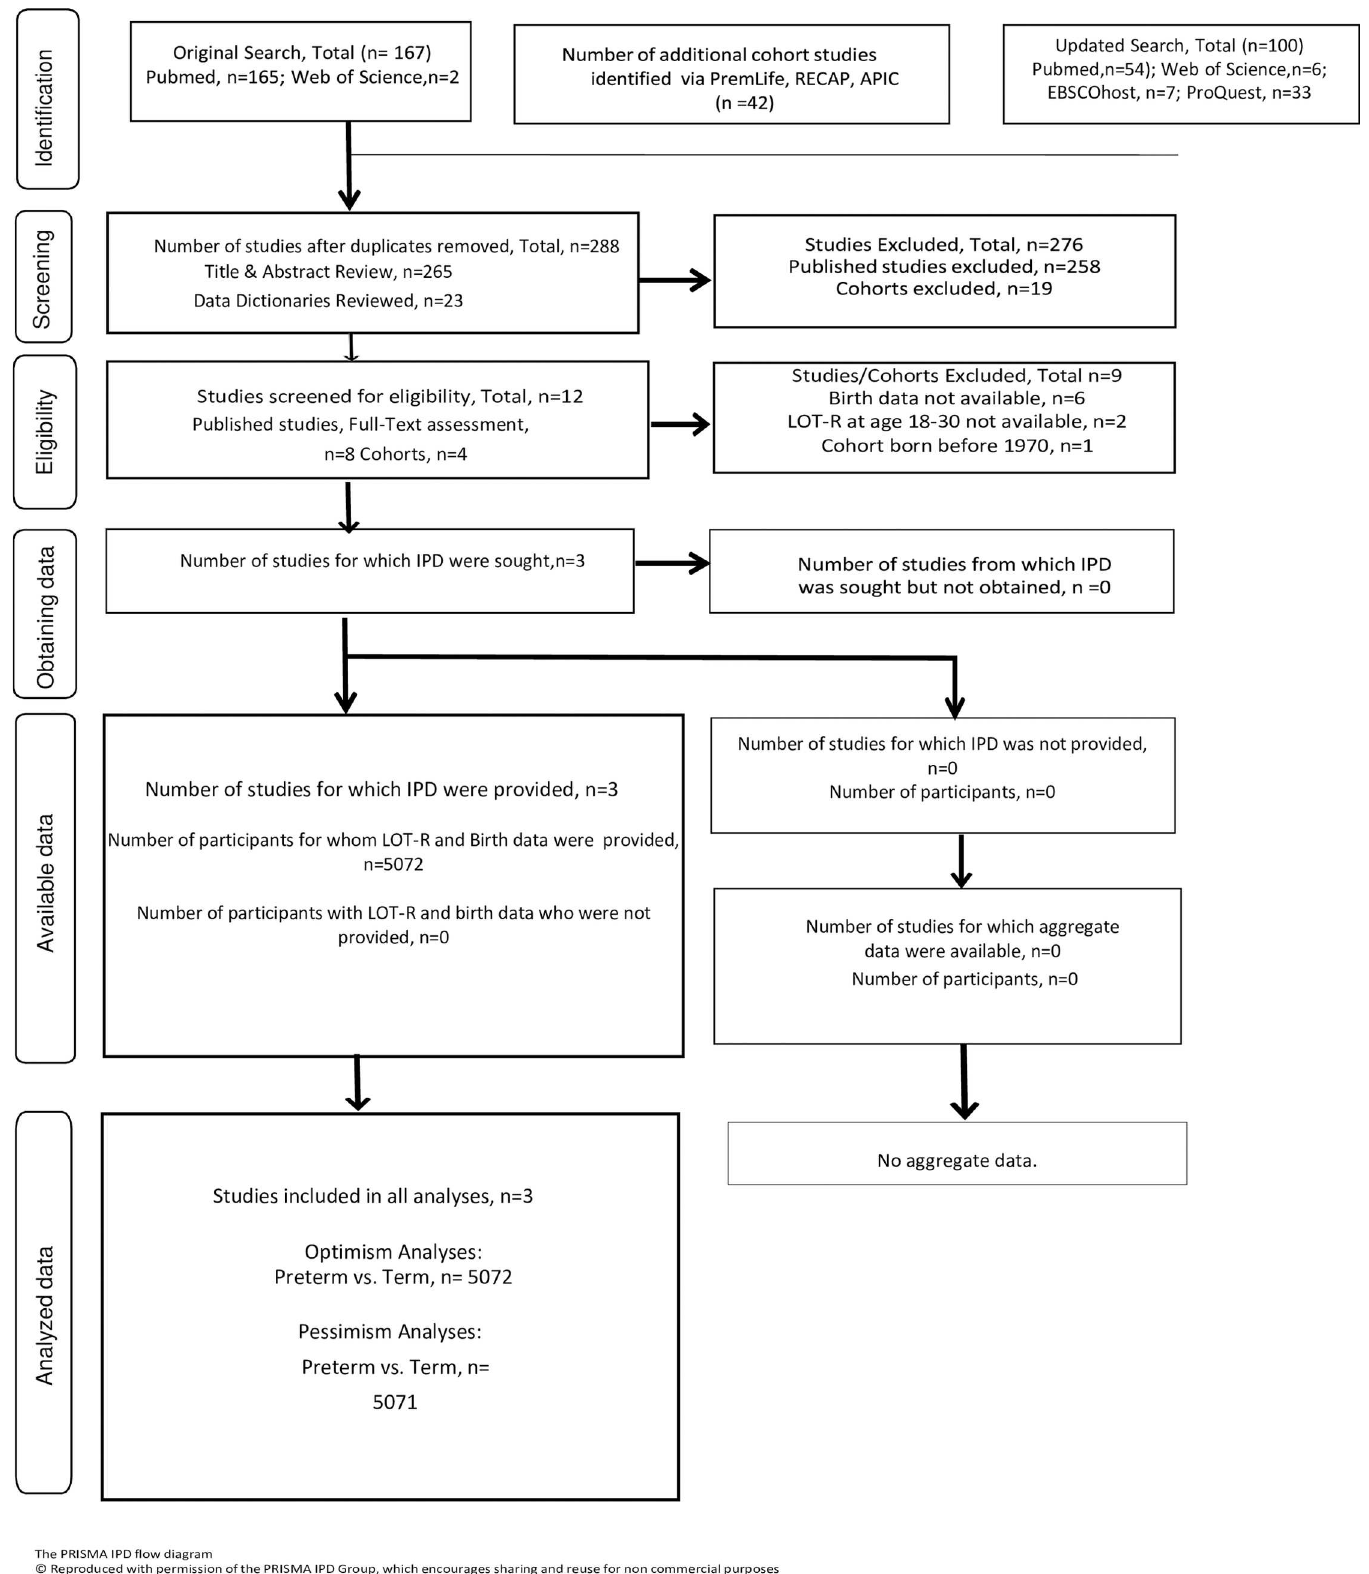
Fig 1. PRISMA flow diagram. https://doi.org/10.1371/journal.pone.0259463.g001 PLOS ONE | https://doi.org/10.1371/journal.pone.0259463 November18, 2021 4 /